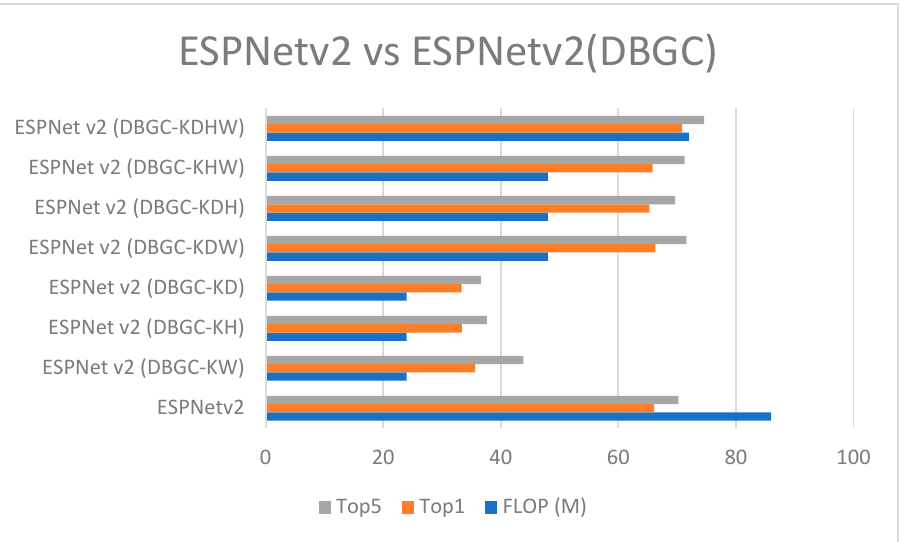
Figure 24. ESPNetv2 versus ESPNetv2 (DBGC).